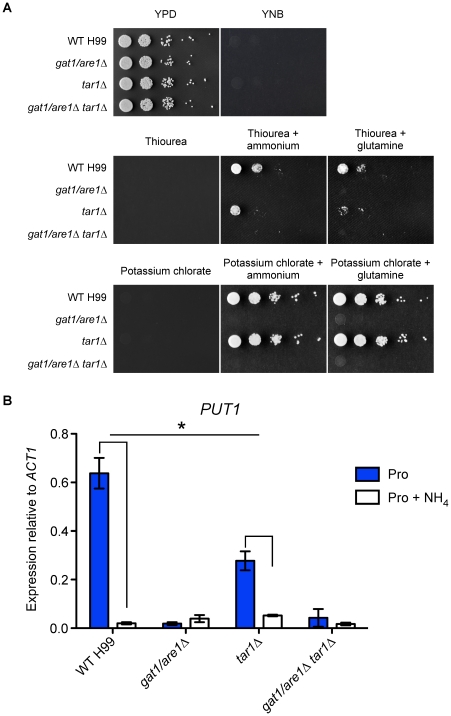
Tar1 plays a role in modulating nitrogen metabolite repression.(A) Tenfold spot dilution assays for nitrogen utilization showed that the tar1Δ mutant exhibited slight sensitivity to 5 mM thiourea when compared to wild-type in the simultaneous presence of 10 mM ammonium or glutamine. (B) cDNA from wild-type H99 and the mutant strains grown in YNB supplemented with proline or proline plus ammonium (10 mM each nitrogen source) were amplified via qRT-PCR using primers against the proline oxidase-encoding gene PUT1 and the control gene ACT1. In the wild-type strain, PUT1 expression was significantly increased in the presence of proline but upregulation was largely abolished when ammonium was also present. In the tar1Δ mutant, PUT1 transcription was intermediate in the presence of proline and upregulation was only partially reduced when ammonium was simultaneously present. Nitrogen metabolite repression sensitivity of PUT1 in the wild-type strain statistically differs from that in the tar1Δ mutant (* denotes P<0.05). In the gat1/are1Δ and double gat1/are1Δ tar1Δ mutants, PUT1 expression was low under both tested growth conditions. Error bars represent standard errors across three biological replicates.